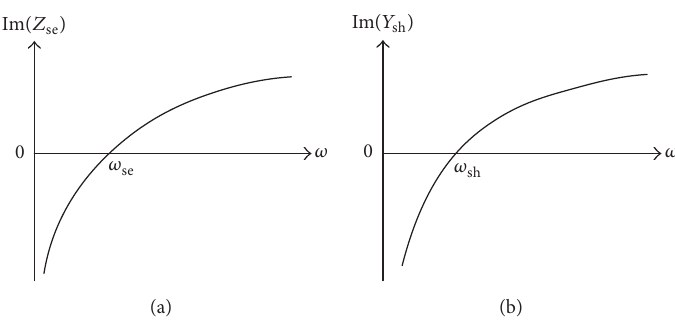
characteristic curve. (b) Shunt admittance se